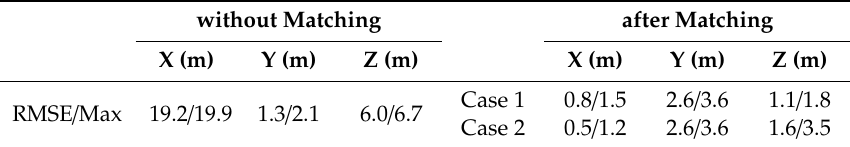
Table 4. Location errors of GPS check points after point-to-surface matching.